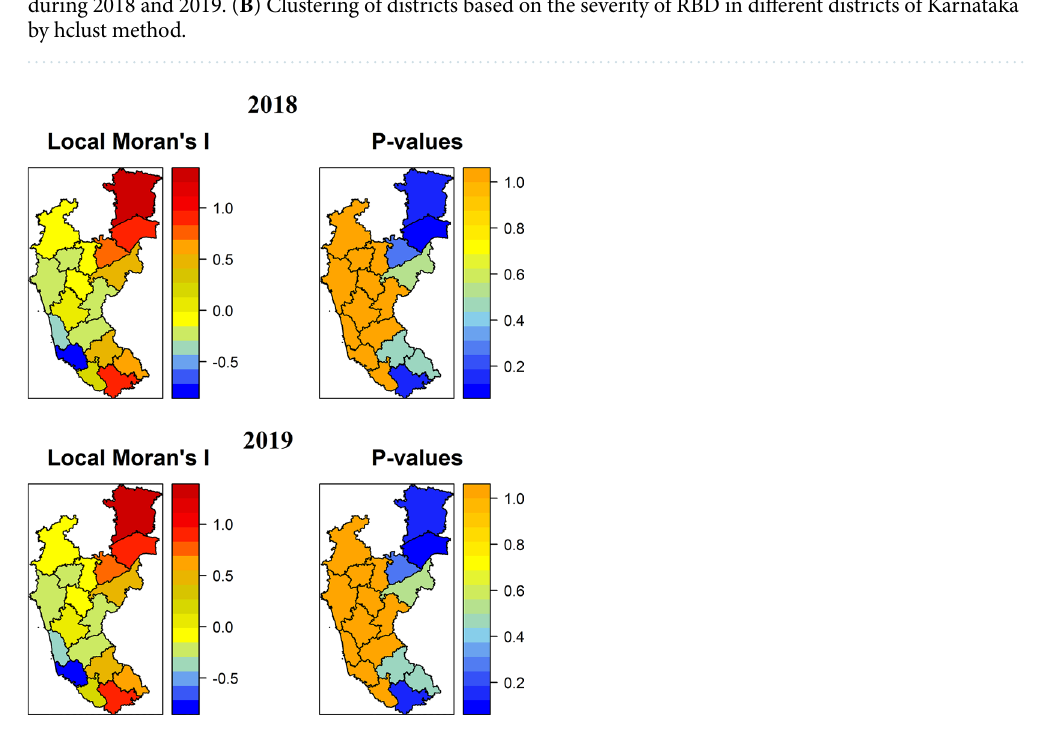
Figure 4. Spatial Point Pattern Analysis of RBD based on Morons I. The statistical significance was observed at two different p -values (< 0.1* and < 0.05**). The varied colored areas displayed the dispersed and aggregated clusters of RBD severity during 2018 and 2019. The maps were created using R software (version